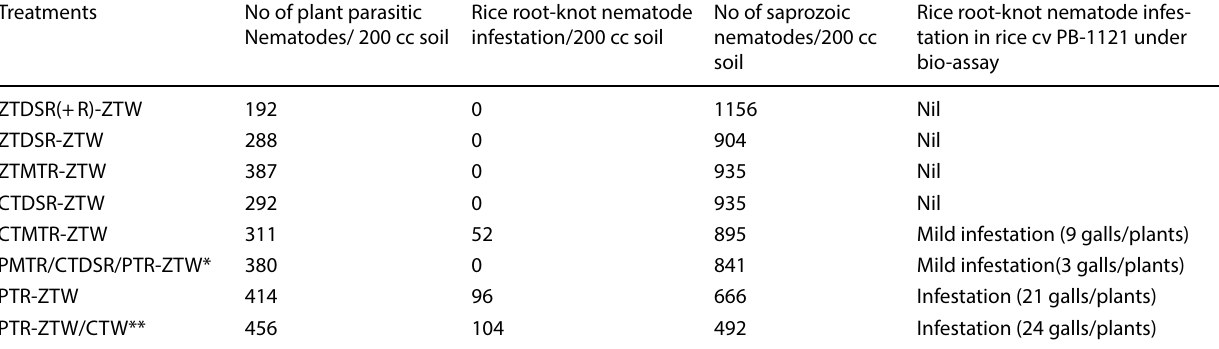
Table 6 Effect of different crop establishment methods on nematodes in rice crop after seven years in the rice–wheat cropping system